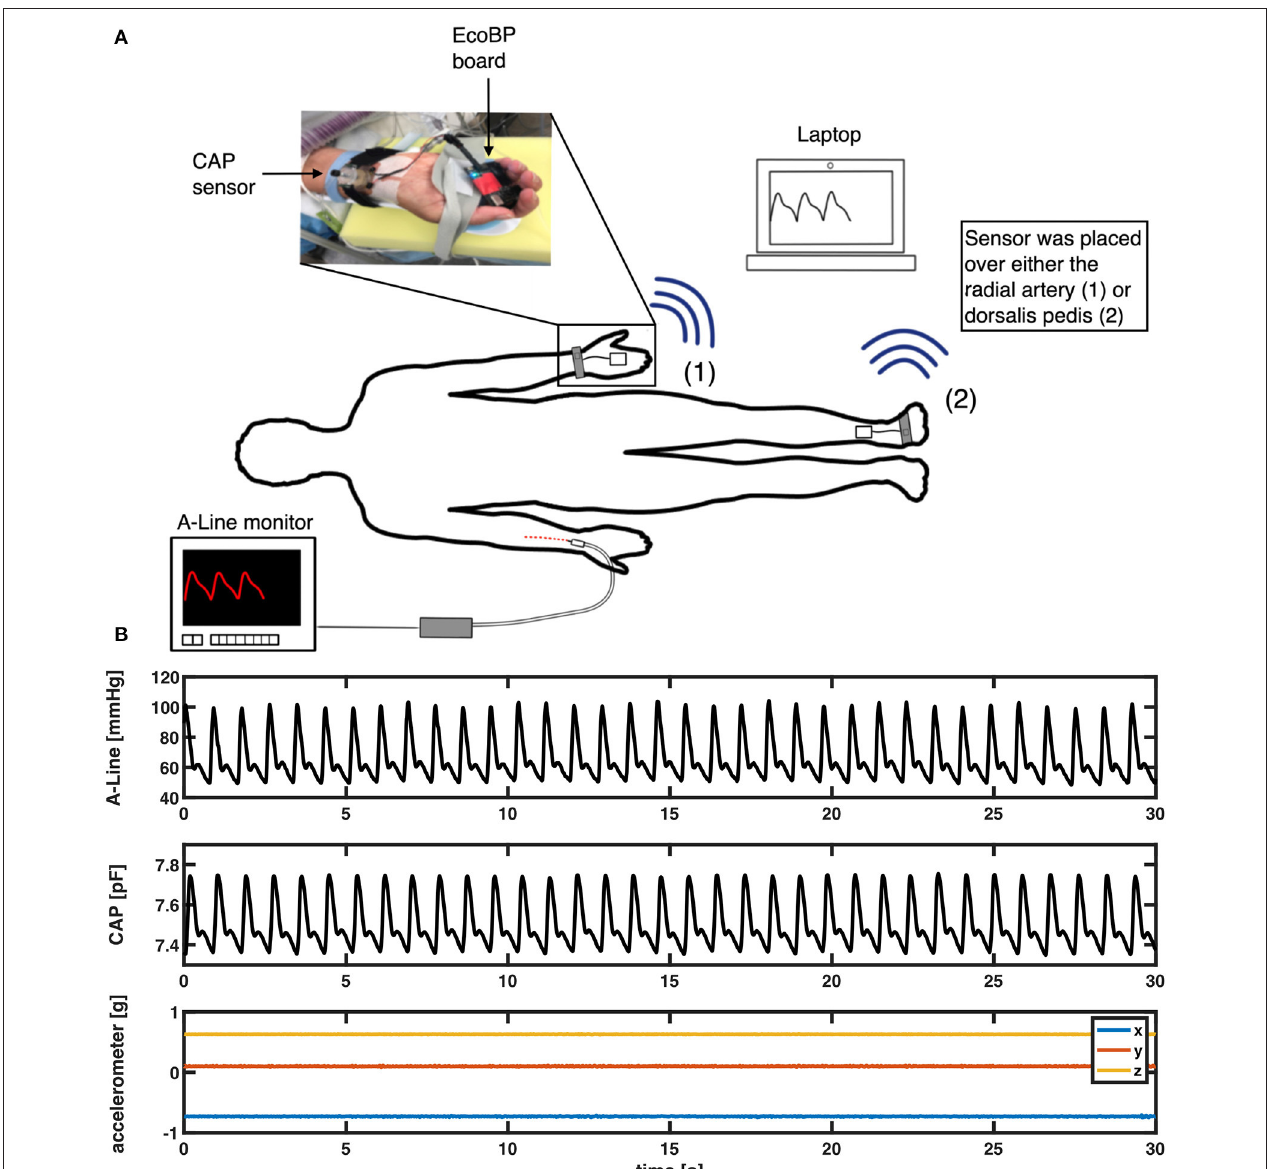
FIGURE 1 | (A) Measurement setup in the OR. An intra-arterial line (A-Line) was inserted in the radial artery. The non-invasive system (CAP) was placed either on the radial artery or the dorsalis pedis artery depending on the procedure. (B) An example of a 30-s segment raw signal acquired from A-Line, the CAP sensor, and the accelerometer data that was used to compare waveform similarity, heart rate, and BP.